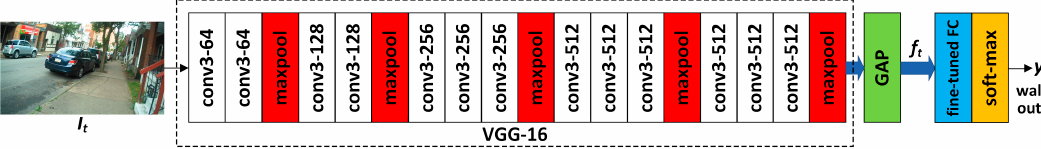
Figure 6. Architecture of the proposed fine-tuned CNN for low-frame-rate photo